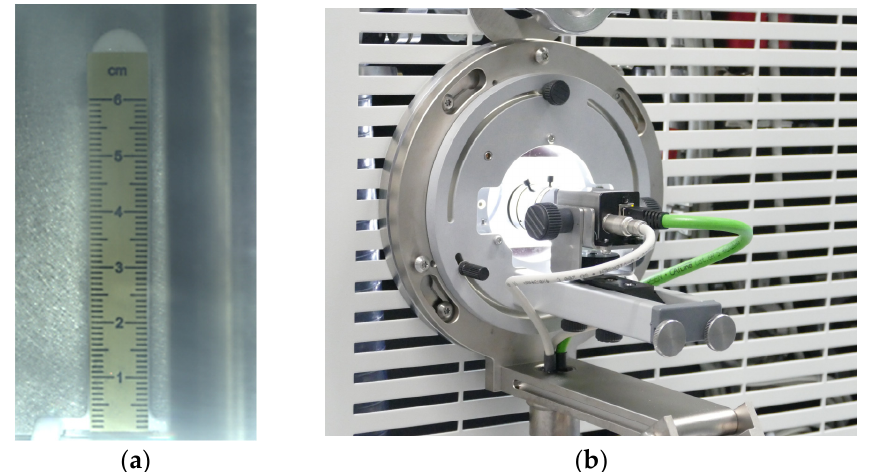
Figure 7. ( a ) Ice ruler and ( b ) position of LyoCam for observation.